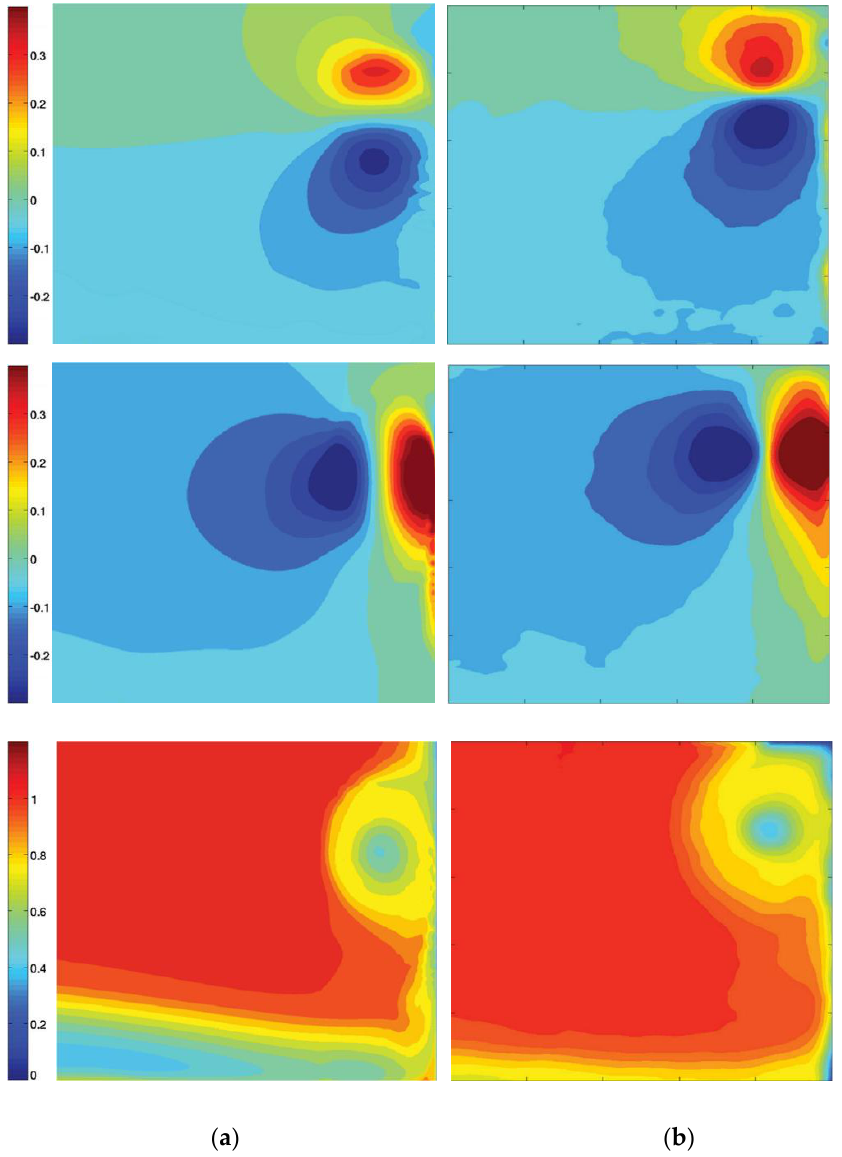
Figure 8. Comparison of contours of velocity components at x / c = 1.0: top: v x , middle: v y , and bottom: v z . ( a ) Present LES. ( b ) Experiment.